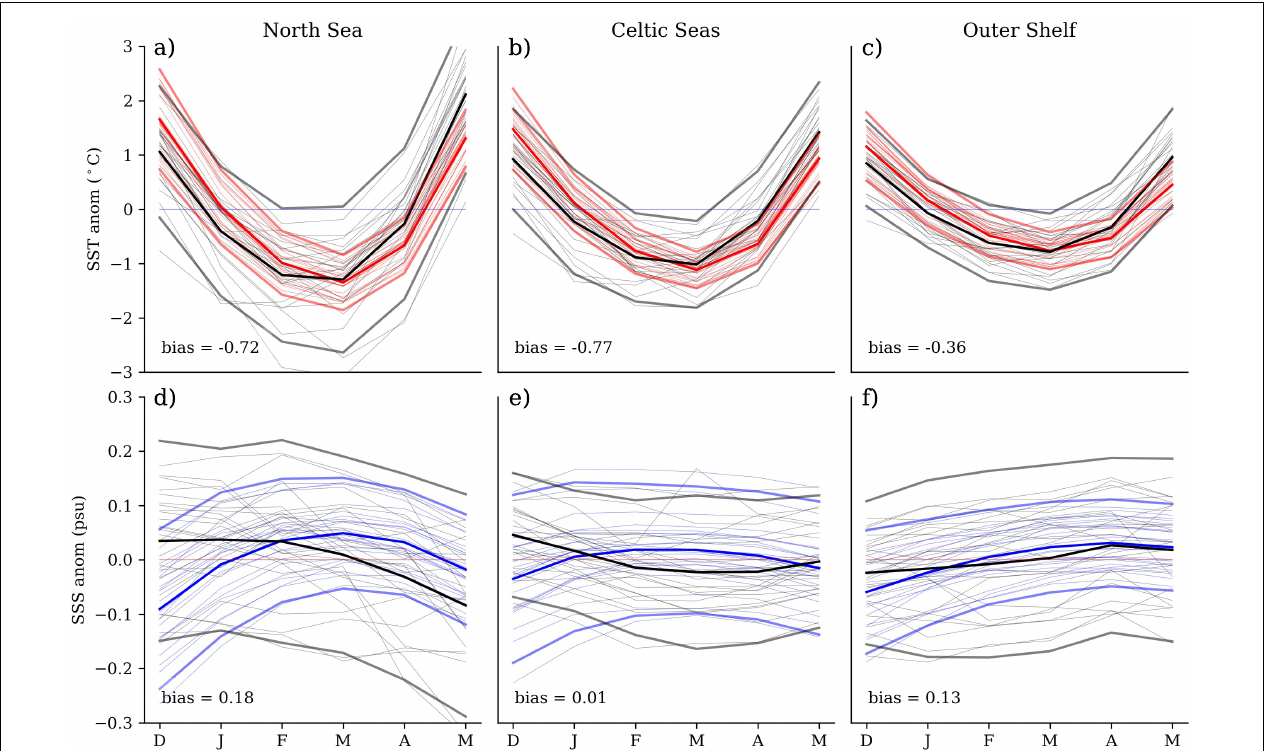
FIGURE 3 | The regional mean seasonal evolution of SST (a–c) and SSS (d–f) for 3 regions [North Sea (a,d) , Celtic Seas (b,e) , and Outer Shelf region (c,f) - the regions are defined in Figure 1a ], for CMEMS (black) and GloSea5 ensemble means (temperature red, salinity blue). For CMEMS, each year (between 1993 and 2016) is given as a thin line, with the climatological mean year as a bold line. Interannual spread for CMEMS and GloSea5 is given with ± 1.96 standard devations. The mean bias is given in each panel. NBT is given in Supplementary Figure 8